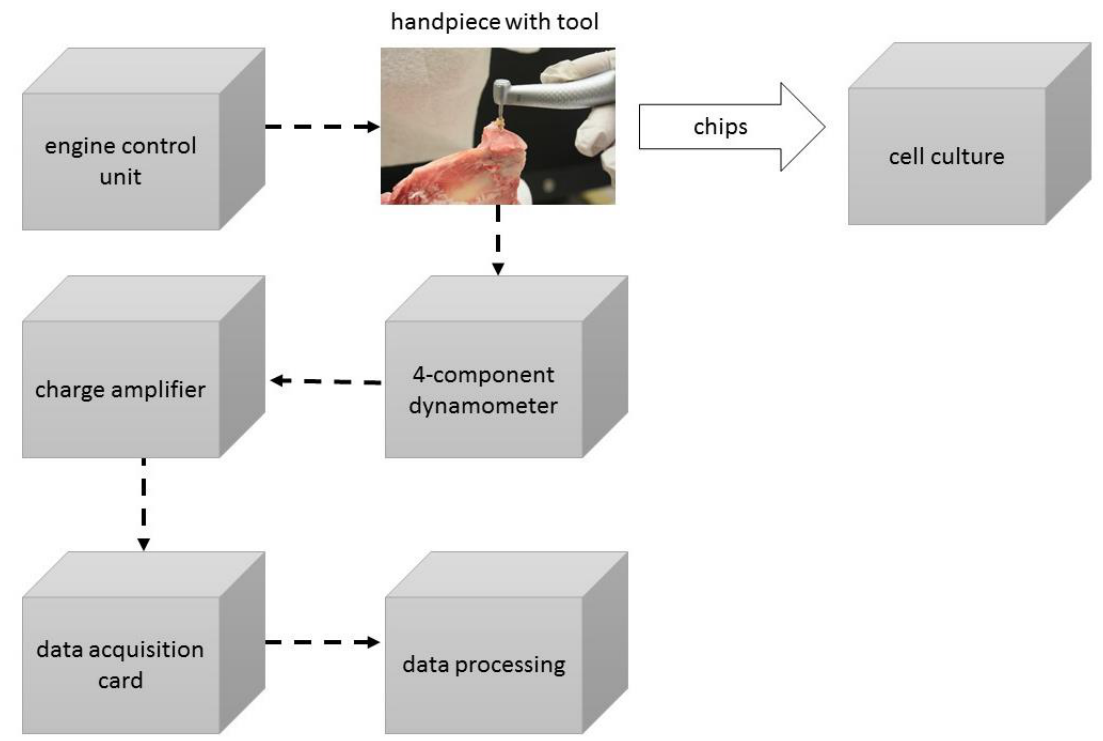
Figure 3. Schematic diagram of the experimental set-up.